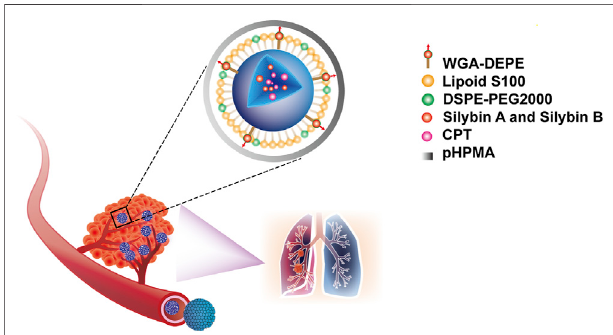
FIGURE 6 | The poly-N-(2-hydroxypropyl) methacrylamide (pHPMA)- coated wheat germ agglutinin-modi fi ed lipid-polymer hybrid nanoparticles, co-loaded with silibinin and CPT